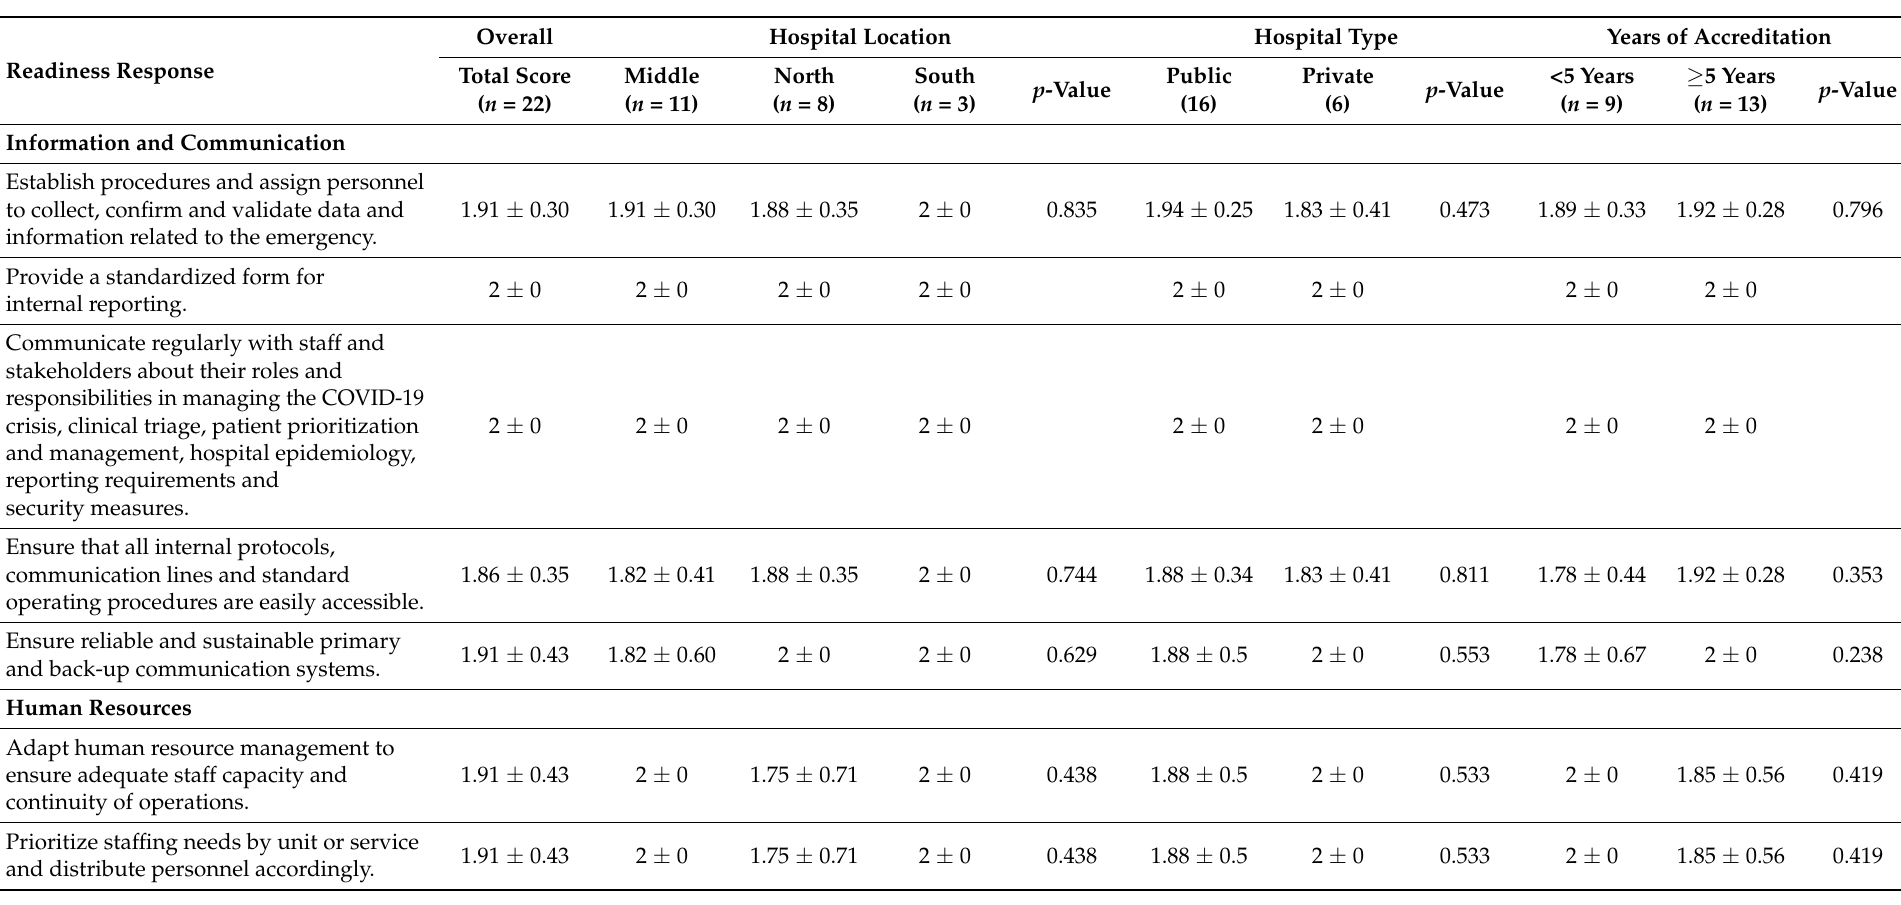
Table 5. Detailed average compliance score of participating hospitals according to response function stratified according to hospital location, type, and years of accreditation for response functions (information and communication, and human